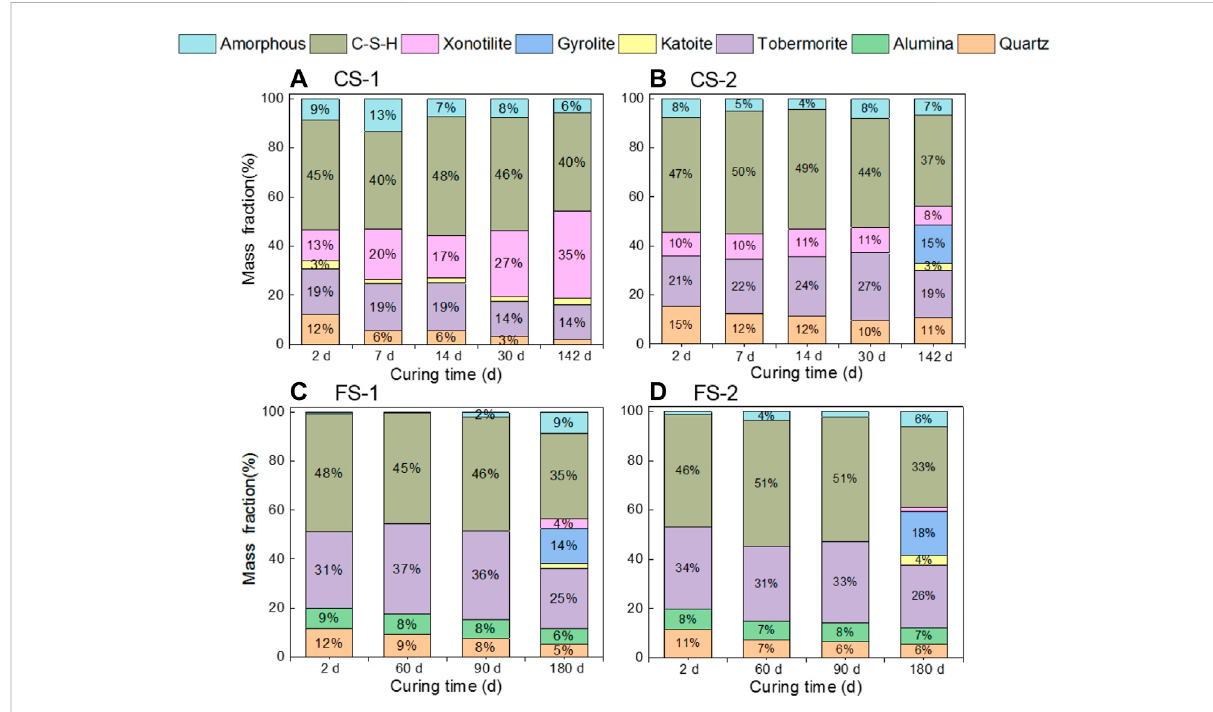
FIGURE 9 (A – D) Phase compositions of hydrated cement quanti fi ed using the hybrid method at various curing